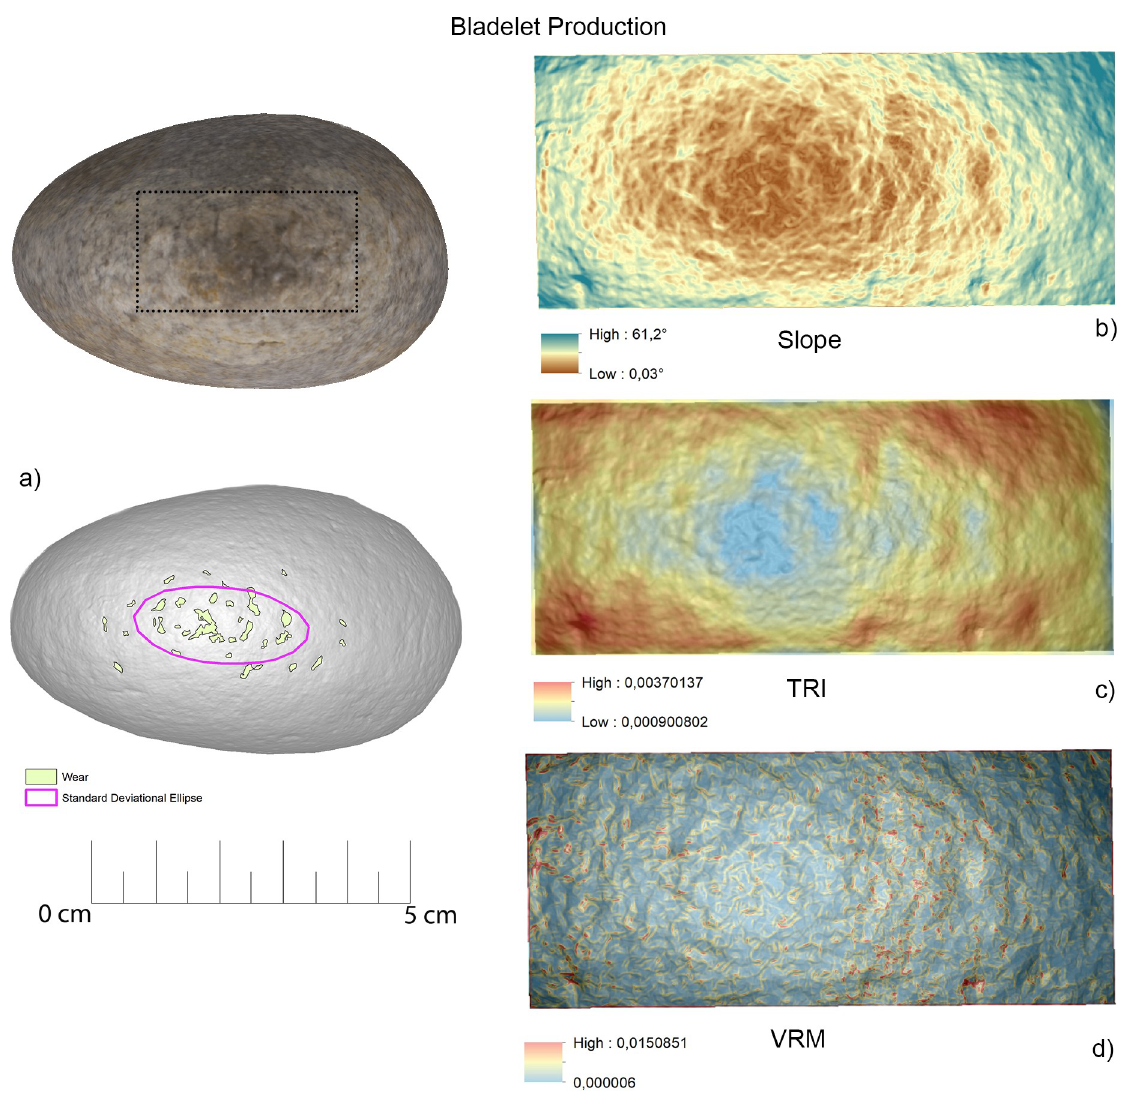
Fig 17. Experimental object utilized for bladelet production. (a) Spatial distribution of the identified wear; (b) slope; (c) terrain roughness index; (d) vector roughness